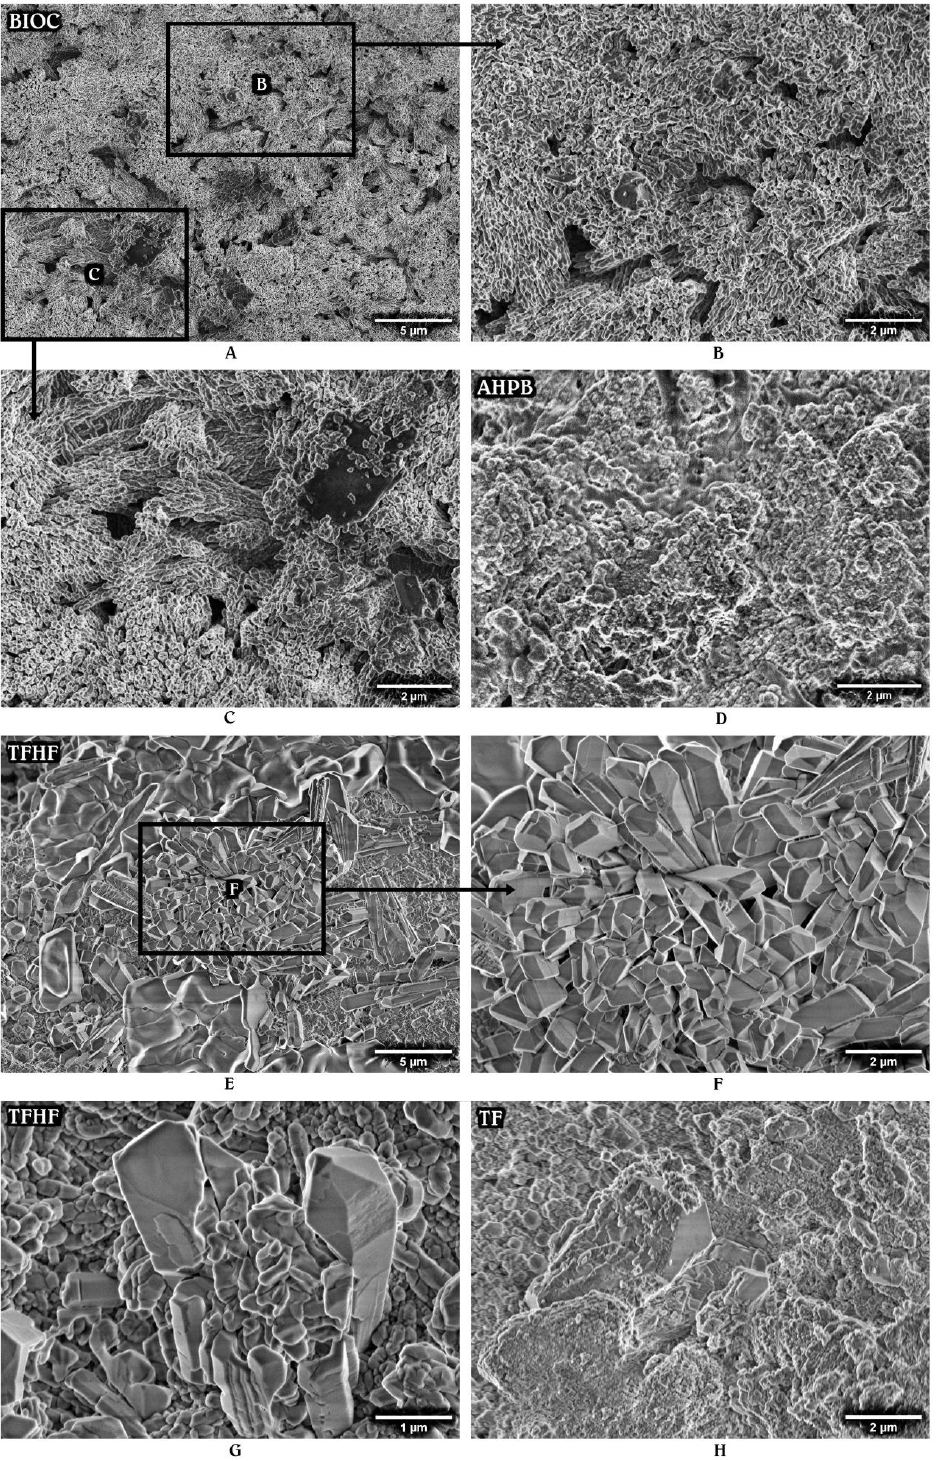
Figure 2. Representative micrographs of premixed hydraulic calcium silicate-based materials: BIOC ( A – C ), AHPB ( D ), TFHF ( E – G ), and TF ( H ) after 28 days of aging in HBSS. Magnification set at ×4.0k and ×10.0k.